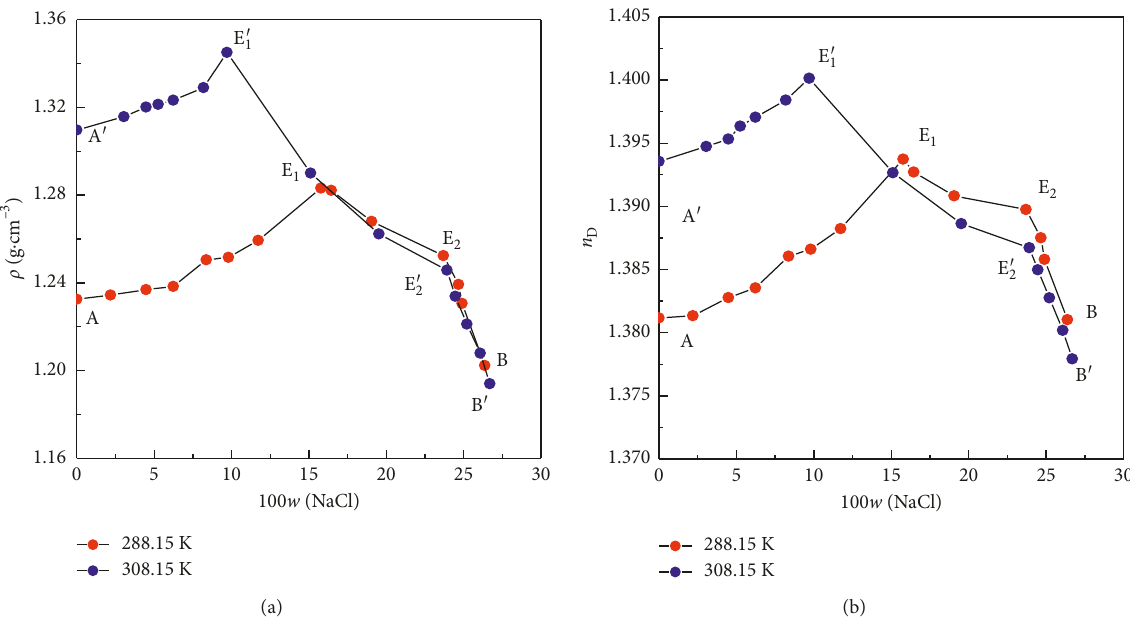
Figure 3: Diagram of physicochemical property versus sodium chloride content for the ternary system (NaCl+NaBO 308.15 K. ( • ) Experimental points at 288.15 and 308.15K; (a) density versus NaCl composition; (b) refractive index versus NaCl